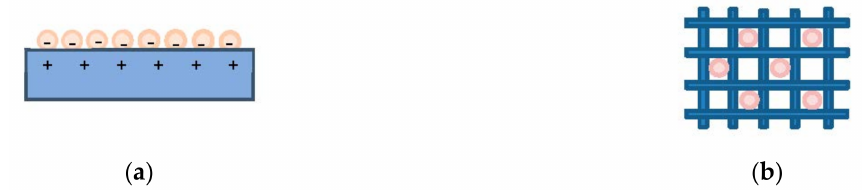
Figure 2. Enzymatic physical immobilization techniques: adsorption ( a ) and entrapment ( b ).